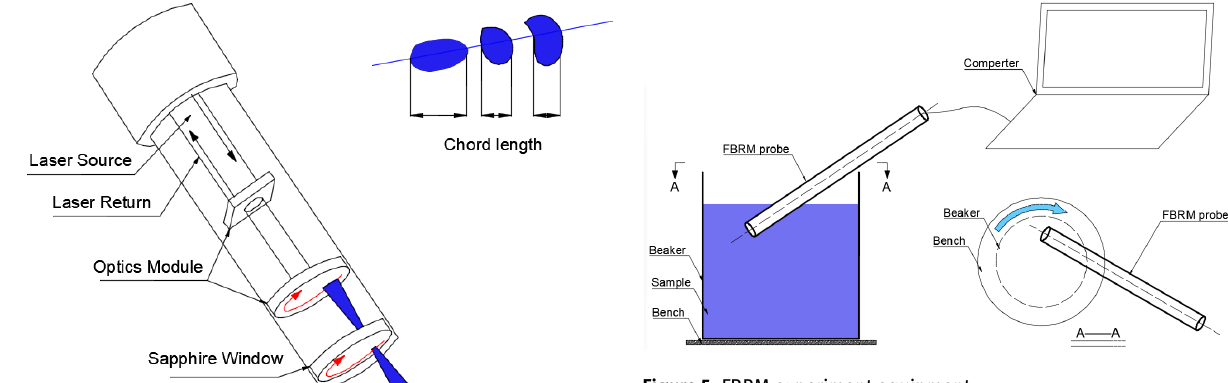
Figure 5: FBRM experiment